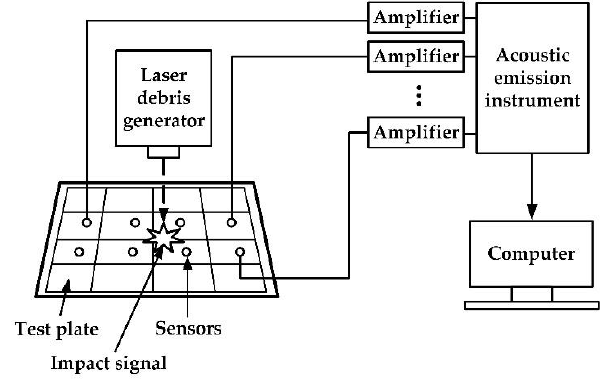
Figure 6. Experiment platform schematic diagram.